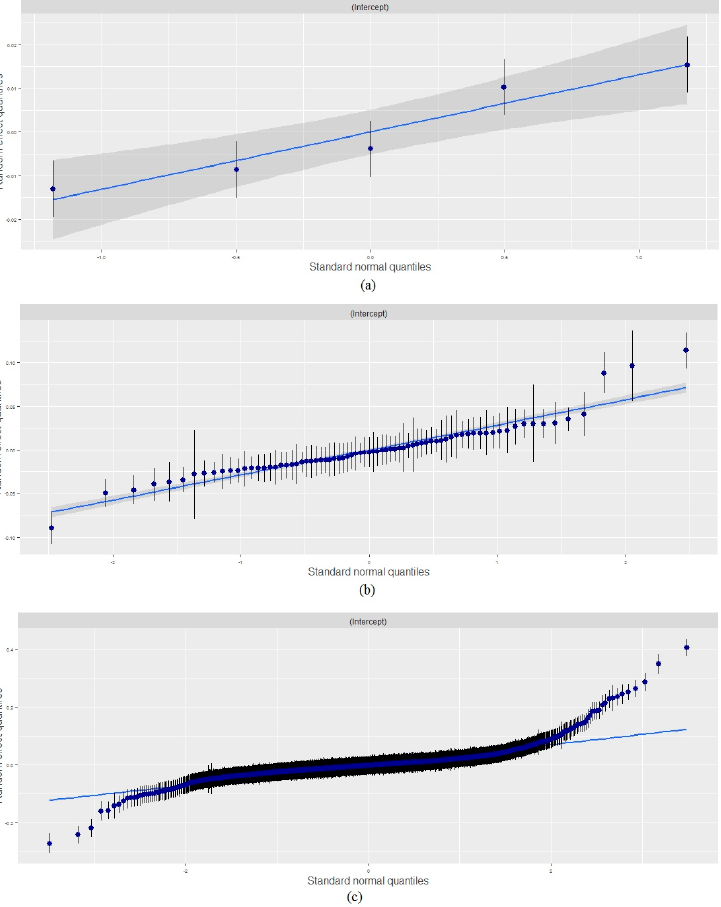
Figure A2. Diagnostics plots of random effects from model 4i: ( a ) for year, ( b ) for regions and ( c ) for municipalities.